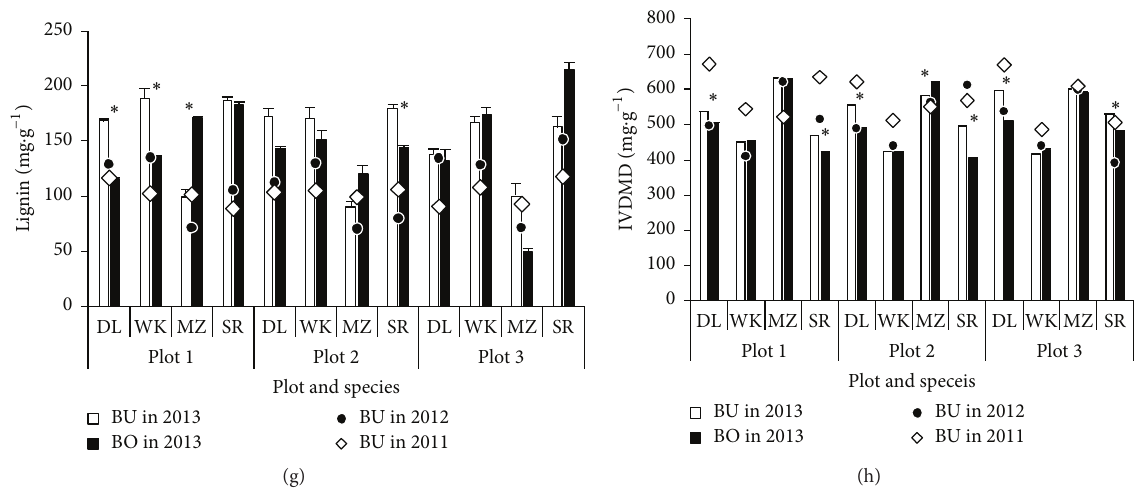
Figure 5: Cellulose (a), hemicellulose (b), and lignin (c) contents and in vitro dry matter digestibility (IVDMD (d)) of 4 species in late autumn on December 20, 2011, and on October 27, 2012 (mean ± standard deviation). ∗ shows the difference between BU and BO areas at 5% level. For both plots and species, refer to Figure 1. Cellulose (e), hemicellulose (f), and lignin (g) contents and in vitro dry matter digestibility (IVDMD (h)) of 4 species in late autumn on December 20, 2011, November 27, 2012, and November 15, 2013 (mean ± standard deviation). ∗ shows the difference between BU and BO areas at 5% level. For both plots and species, refer to Figure